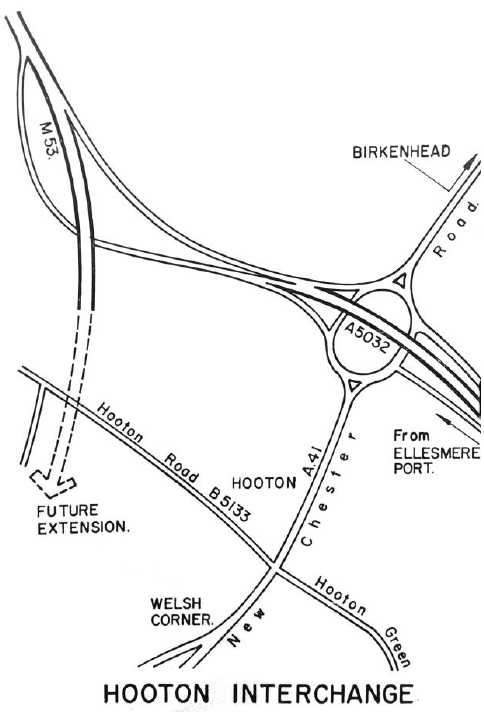
Figure 11. Illustrated map showing proposed southbound M53 extension. (Department of the Environment [45], © Crown Copyright (n.d.)).